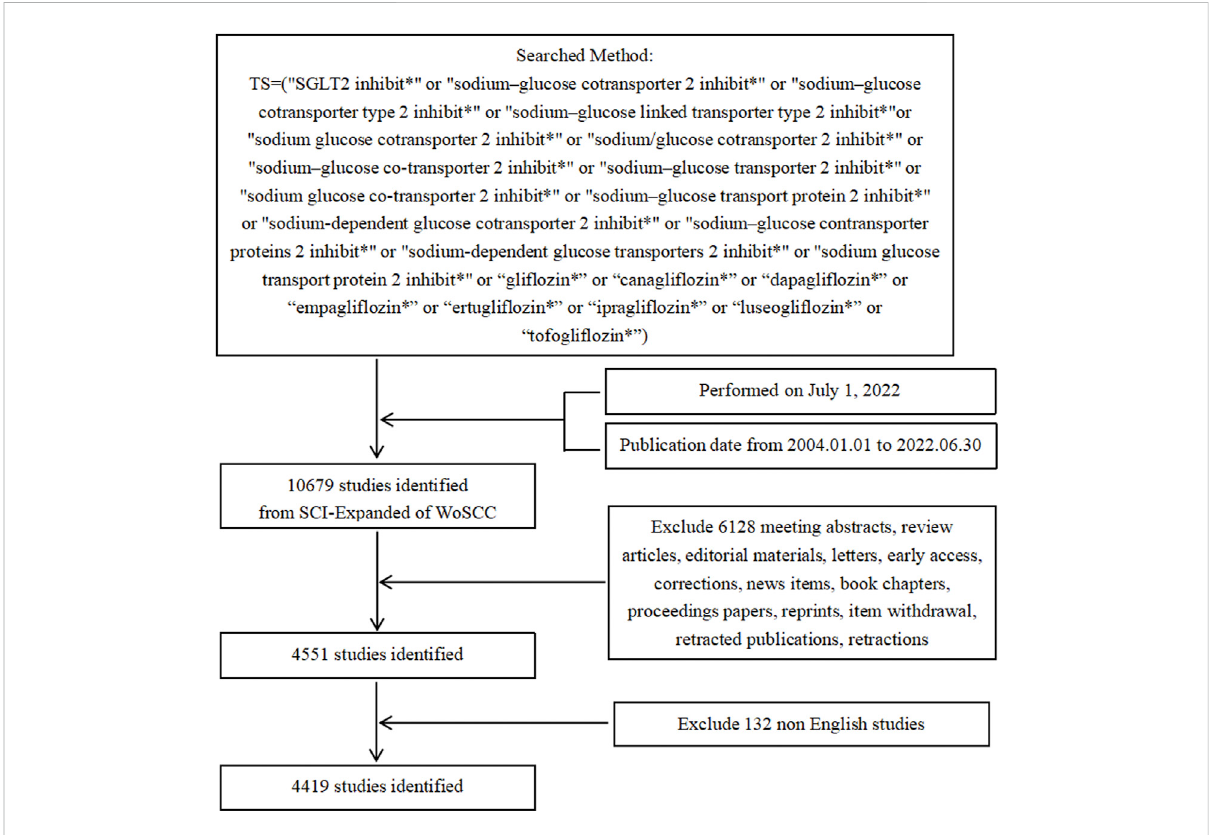
FIGURE 1 Flowchart of the screening